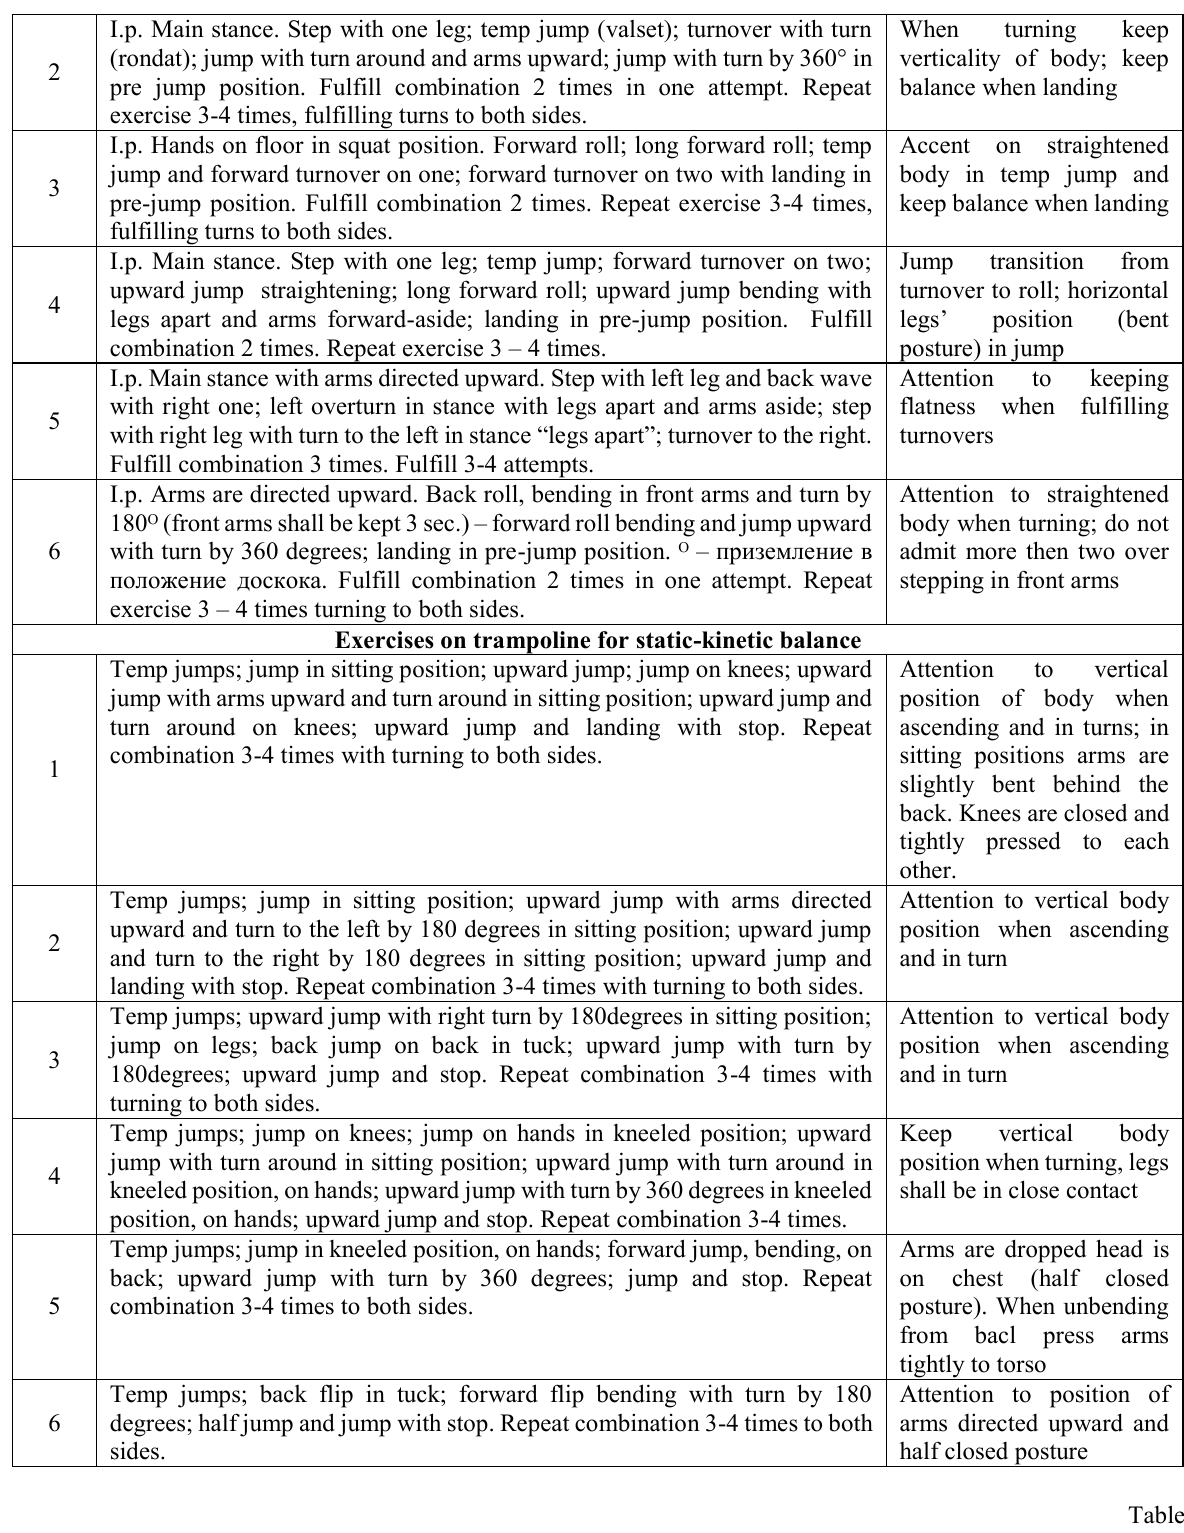
Algorithm of exercises’ fulfillment o coordination training program for persons, specializing in sport kinds of gymnastic №